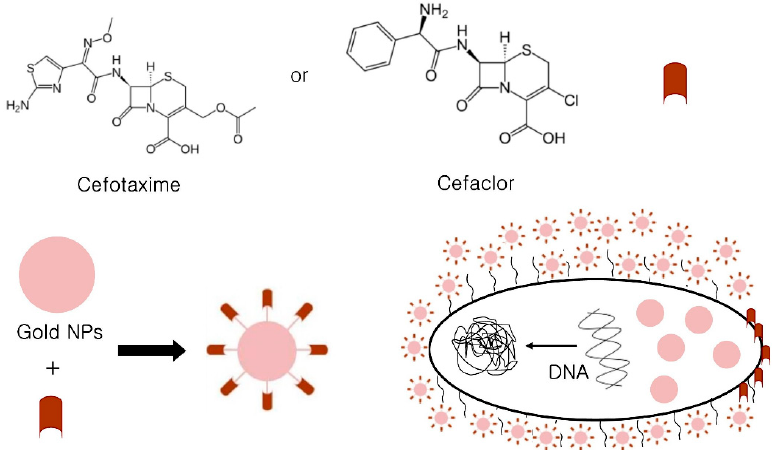
Figure 2. Proposed antibacterial mechanisms of antibiotic-conjugated AuNPs. AuNPs act as antibiotic carriers and facilitate access to bacterial cell walls. Cefaclor or cefotaxime damage cell walls and enable AuNP entry, and AuNPs then prevent DNA from unwinding.